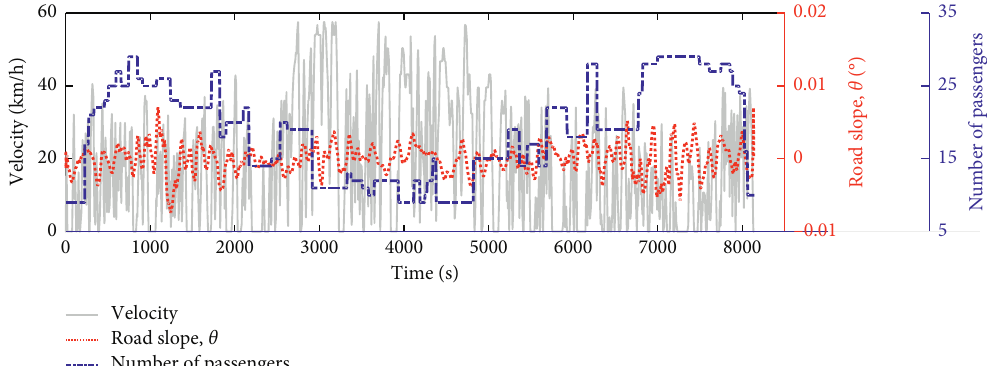
Figure 19: The synthesized driving cycle including passengers.